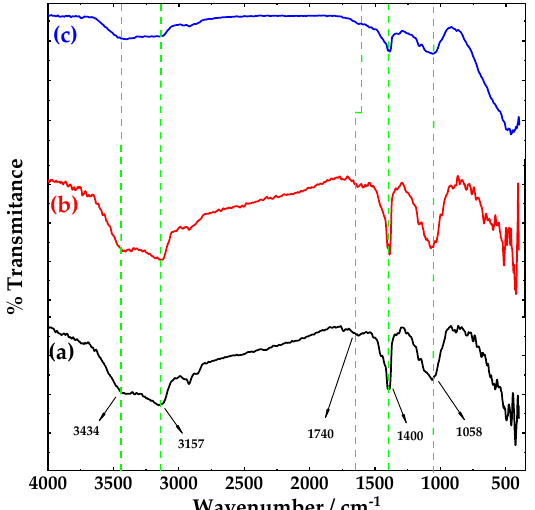
Figure 1. FTIR spectra of (a) pristine carbon nanotubes (CNTs), (b) functionalized CNTs and (c) ZrO 2 -fCNTs in a range from 4000–400 cm −1 .